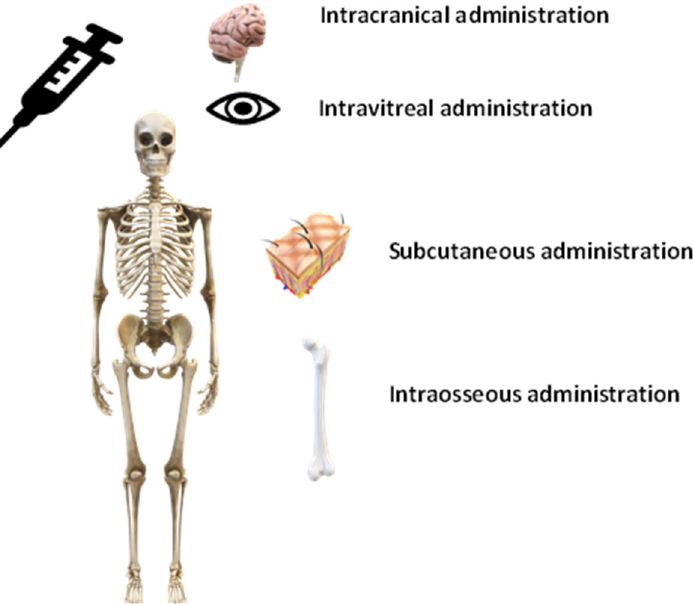
Figure 4. Overview of several possible methods of non-oral administration of encapsulated agents or cells within personalised therapies.